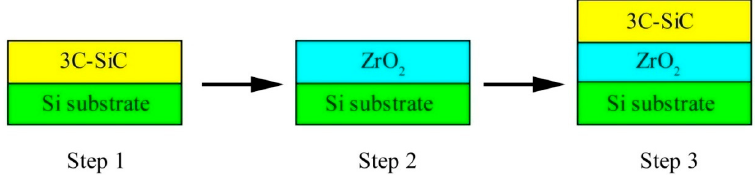
Figure 1. The flow chart of preparation process of 3C-SiC/ZrO 2 thin film.